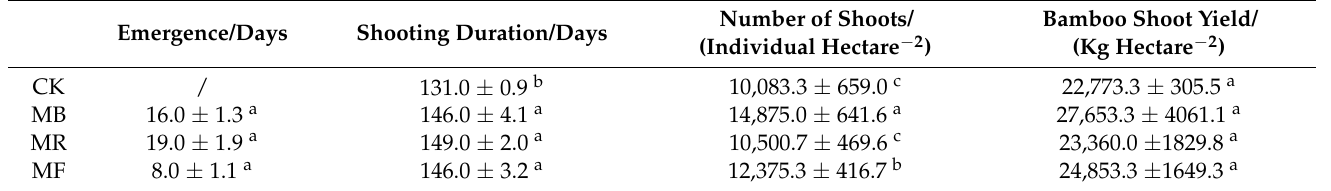
Table 1. The effect of mulch treatments on shooting periods and the number of shoots.